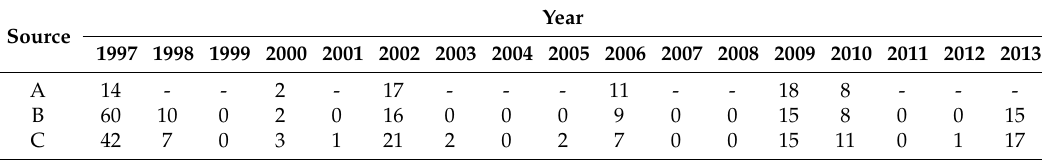
Table 2. Comparison of numbers of flood fatalities in the Czech Republic reported in di ff erent sources for the 1997–2013 period: A—Br á zdov á [48], B—Punˇcoch á ˇr [78], C—this